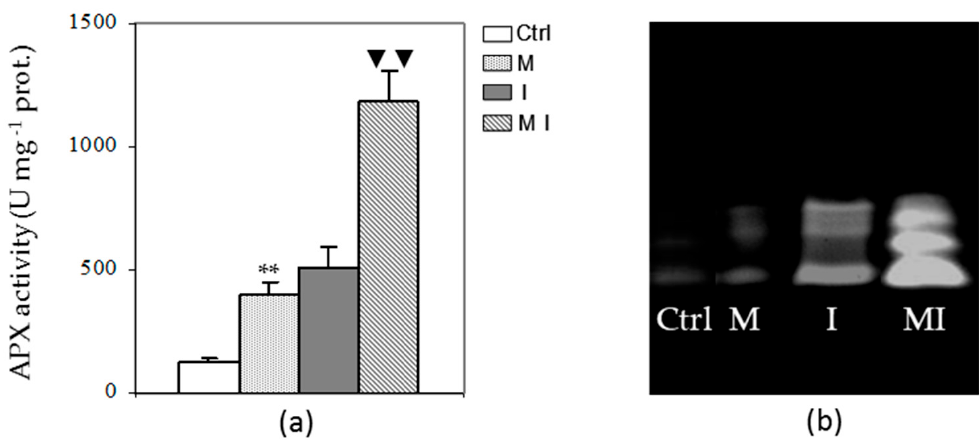
Figure 3. Spectrophotometric activity ( a ) and electrophoretic profile after Native-PAGE ( b ) of ascorbate peroxidase (APX) in the cytosolic fraction of artichoke control plants (Ctrl), mycorrhizal plants (M), plants inoculated with Verticillium dahliae (I), and in mycorrhizal plants inoculated with V. dahliae (MI); 1 U = 1 nmol of ascorbate oxidized min − 1 ; prot. = proteins. The results are given as the mean values of at least five experiments ± SD; * * and ▼▼ indicate values significantly different from the control (Ctrl) and from the artichoke inoculated with V. dahliae , respectively, by the Student’s t test with p < 0.01.